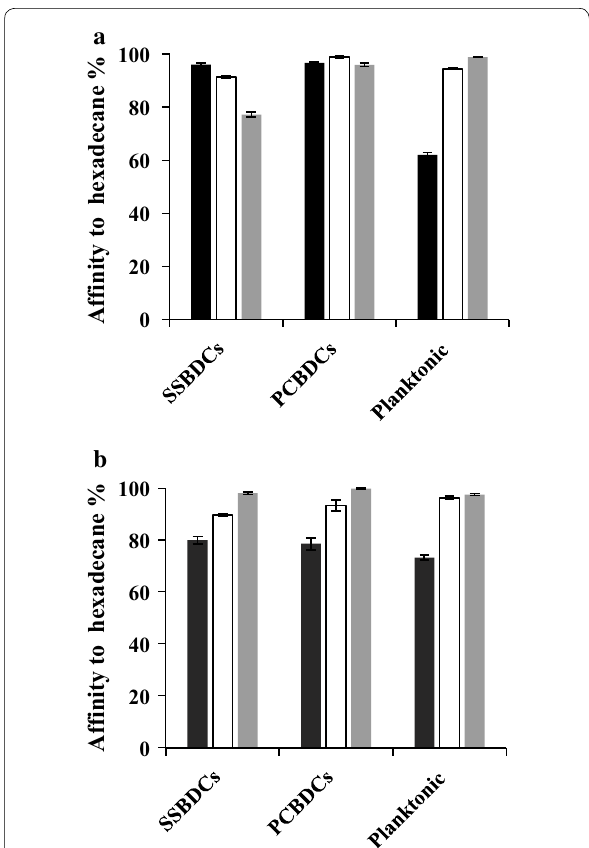
Fig. 2 Affinity of planktonic and biofilm detached Staphylococcus aureus cells to hexadecane. Cells grown, at 20 °C (black square), 30 °C (white square) and 37 °C (grey square). SSBDCs represents the stain‑